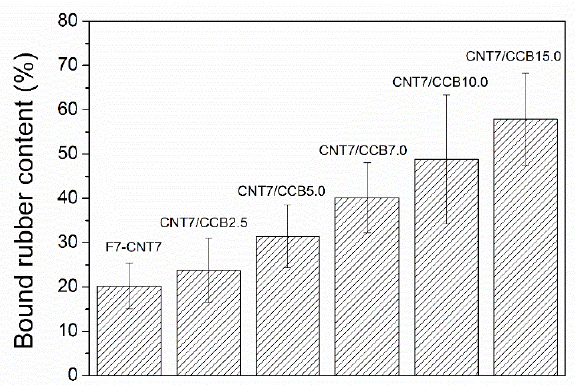
Figure 6. Bound rubber contents of ENR–FeCl 3 filled with CNTs (F7-CNT7) and CNT–CCB hybrid filler with various CCB loadings at 2.5, 5.0, 7.0, 10.0 and 15.0 phr.